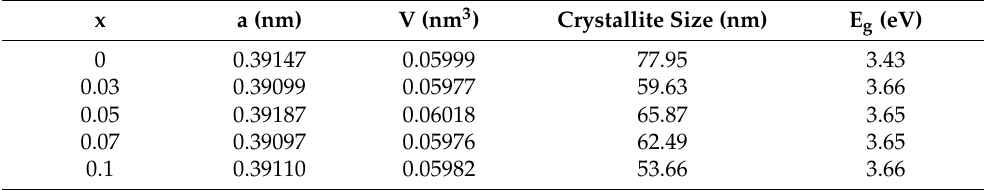
Table 1. Cell parameters, unit volume, crystallite size, and bandgap energies for the Sr 1-x B ix TiO 3 perovskites.